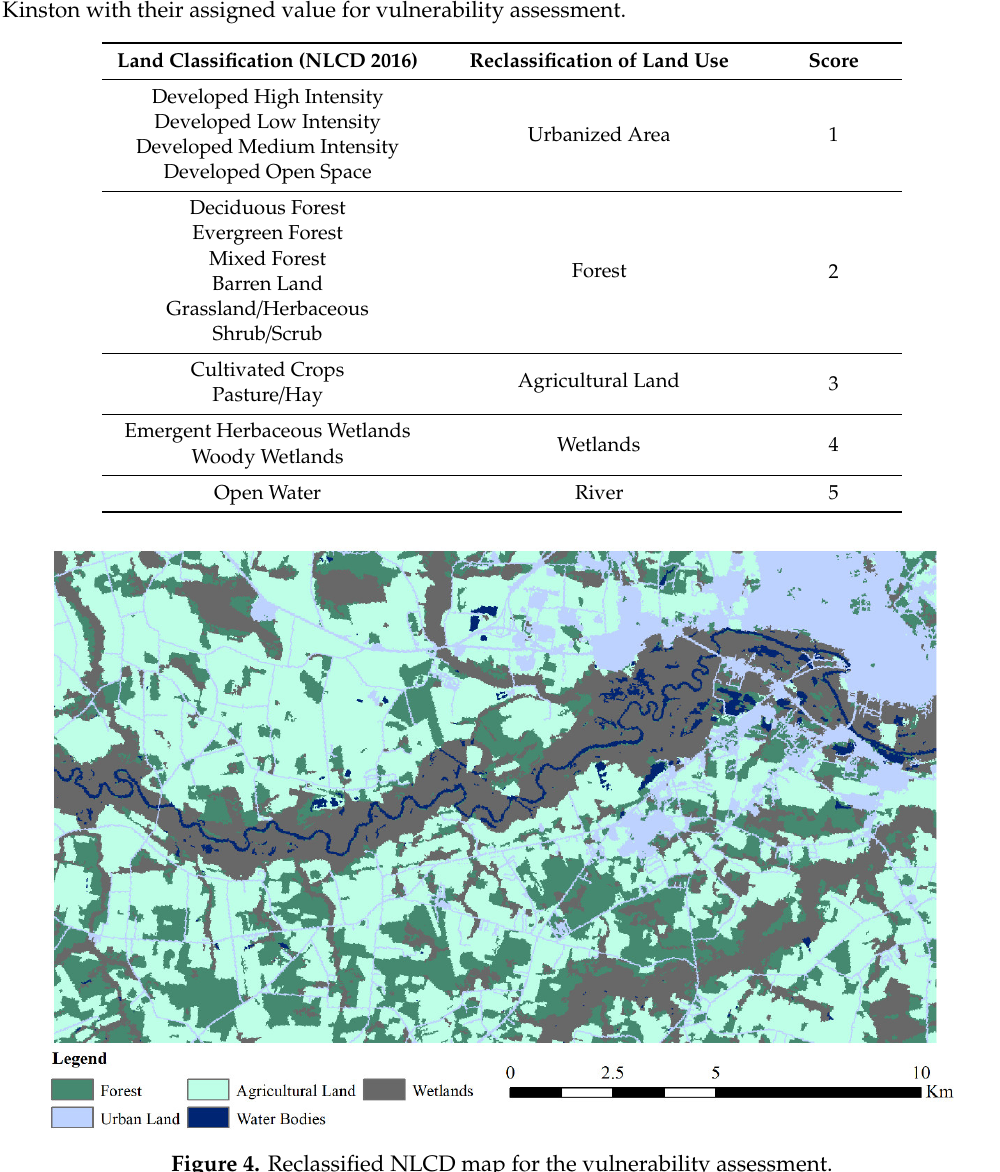
Figure 4. Reclassified NLCD map for the vulnerability assessment.